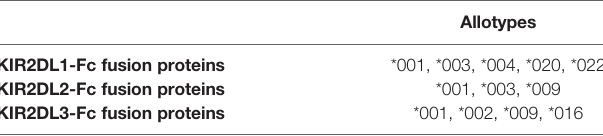
TABLE 2 | Overview of generated KIR2DL-Fc fusion